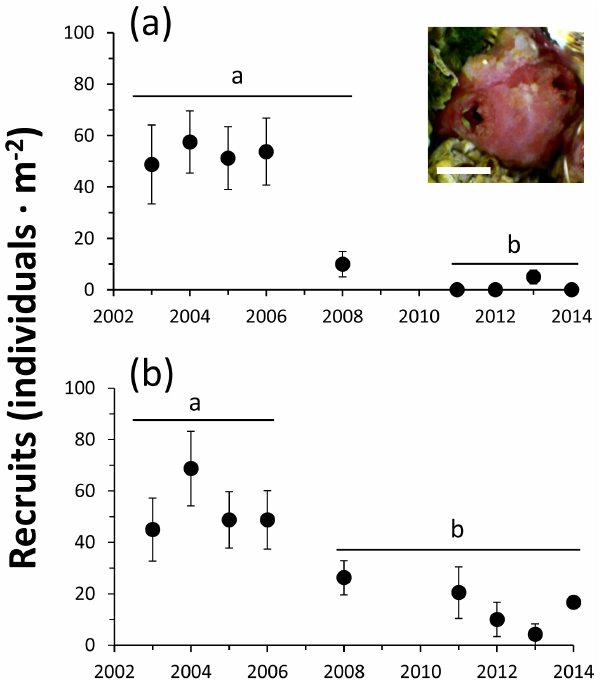
Figure 5. Pyurapraeputialis. Temporal changes in the number (mean 6 SE) of recruits (individuals m 2 2 ) recorded around the siphonal and basal area of conspecifics on rocky intertidal platforms at AAA (a) and El Way (b). Values with different letters depict mean values with significant differences. The inserted picture shows a small recruit in the siphonal area of an adult conspecific (scale bar =0.3 cm).